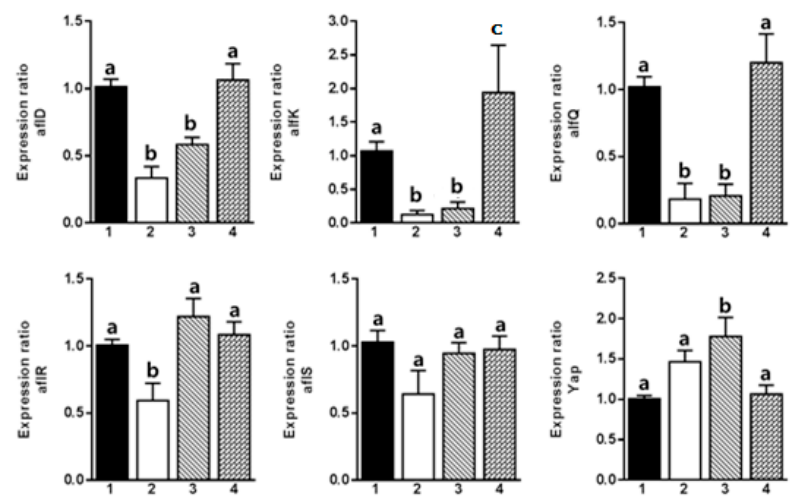
Figure 2. RT-PCR results of aflatoxin biosynthesis using six genes ( aflD , aflK , aflQ , aflR , aflS , and yap ) regulated by 4-hydroxy-7-methyl-3-phenyl coumarin ( 1 ). 1: control; 2: 1000 μ g/mL of 1 ; 3: 100 μ g/mL of 1 ; 4: 10 μ g/mL of 1 ). Different letters indicate statistically significant differences between experimental groups analyzed by a Student’s t -test ( p < 0.05).